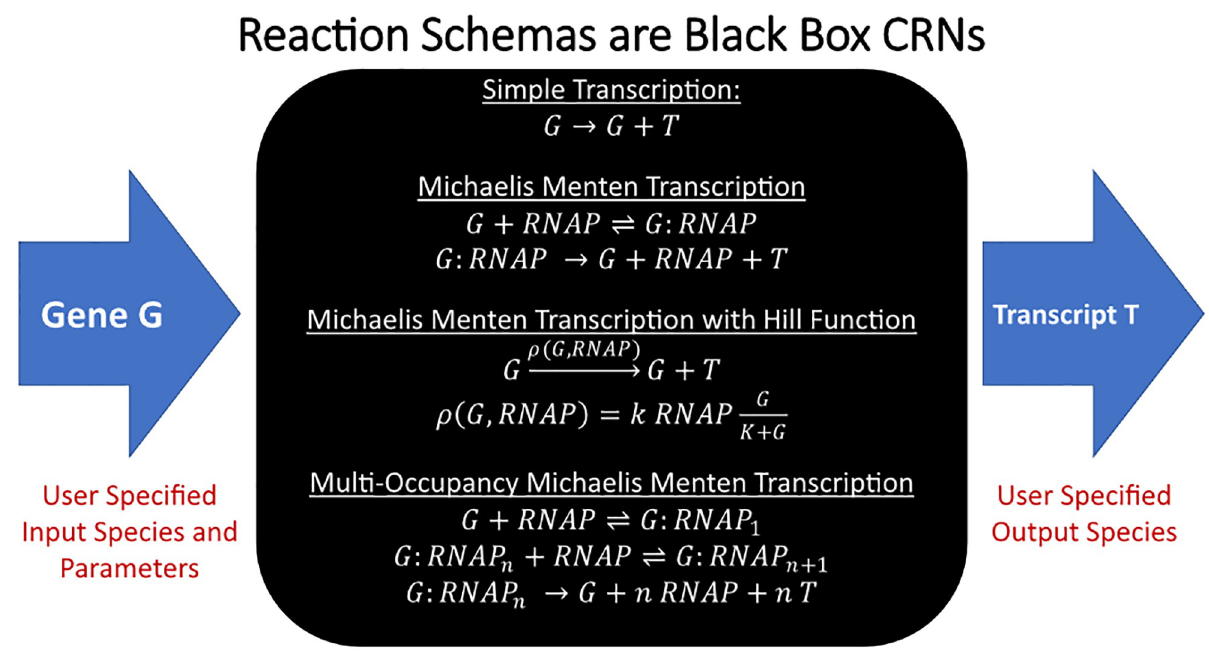
Fig 1. Mechanisms (reaction schemas) representing